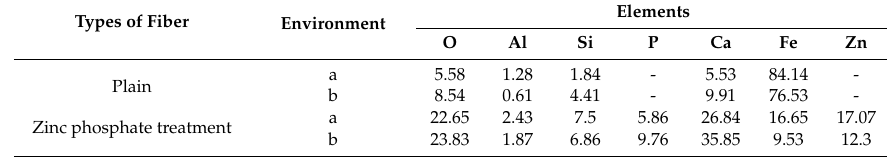
Table 5. EDS of two kinds of steel fiber pulled out from the concrete before and after